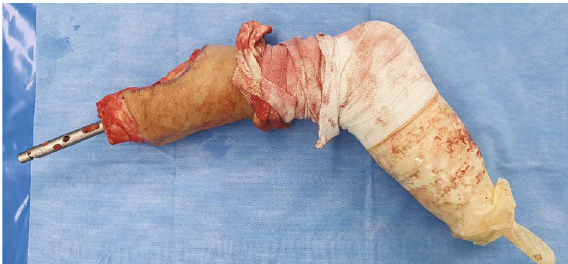
Figure 3: The amputated limb and IM nail were removed from the lower extremities together.